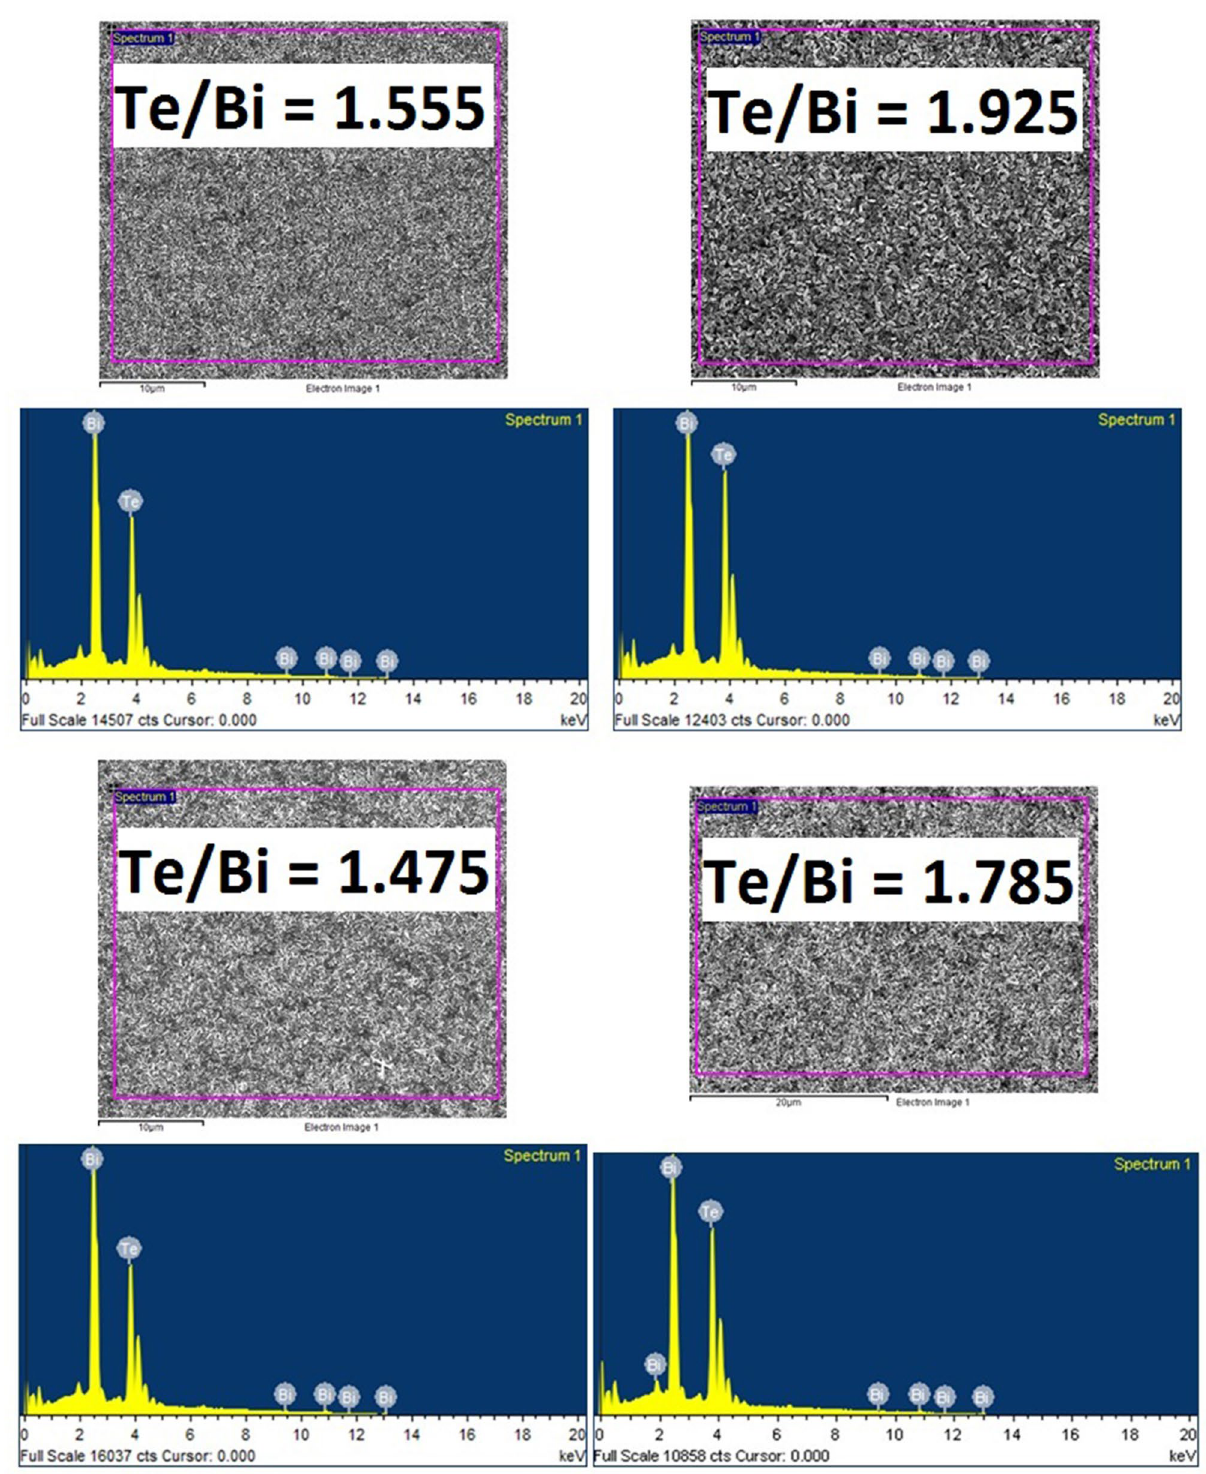
Figure 1. EDS mapping images and spectrums of the selected bismuth telluride (Bi–Te) thin films deposited at high substrate